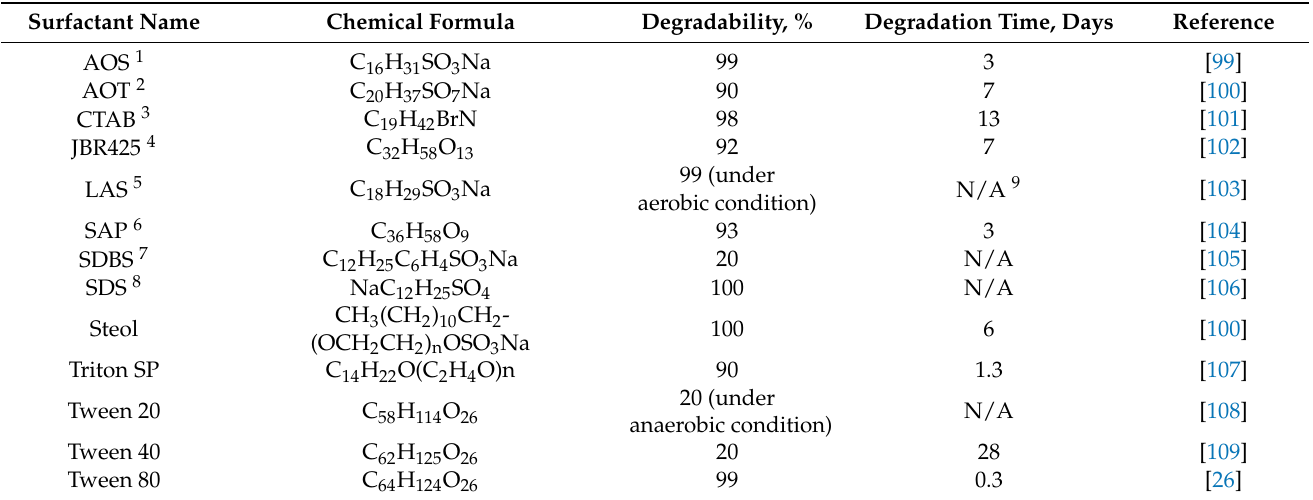
Table 3. Degradability of some